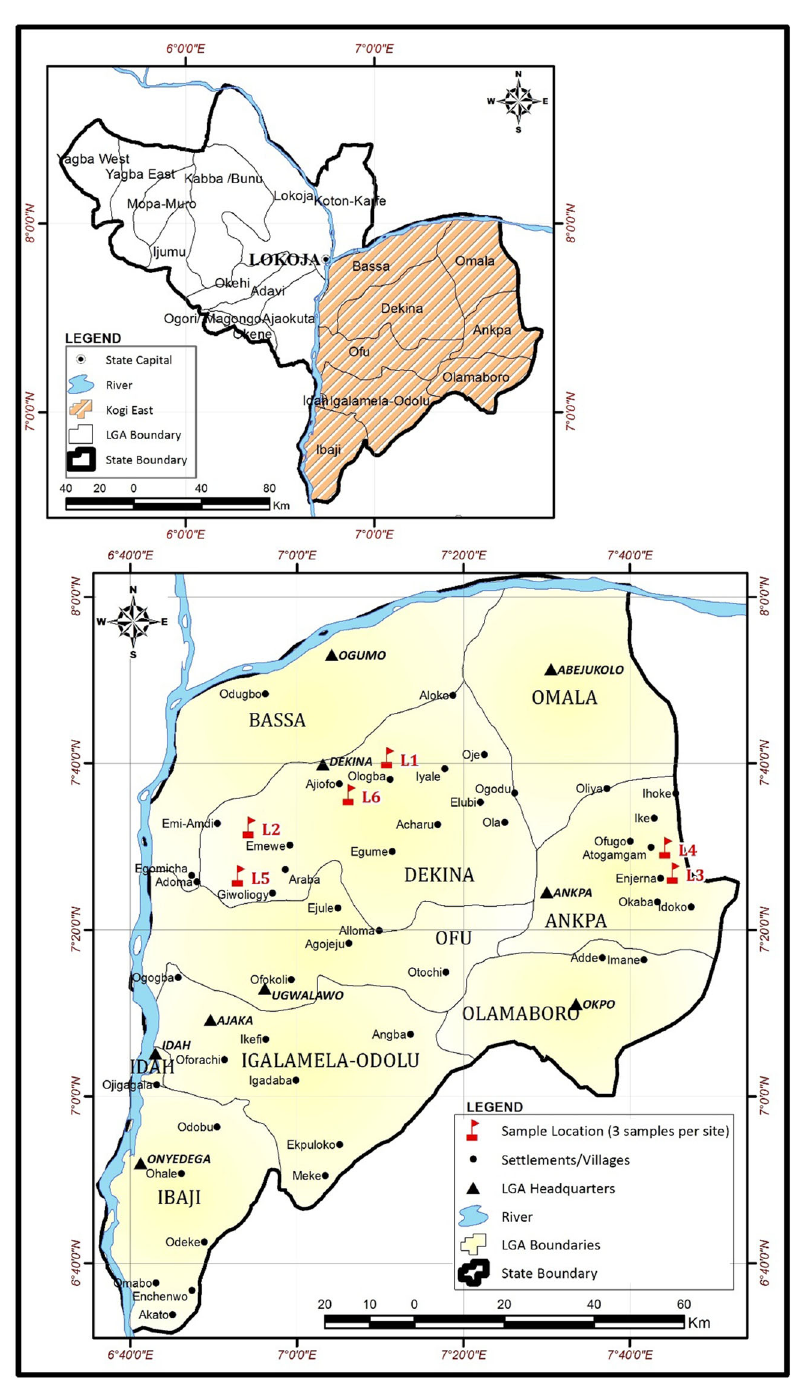
Fig. 3 Location map of Coal sample occurrences (Scale: